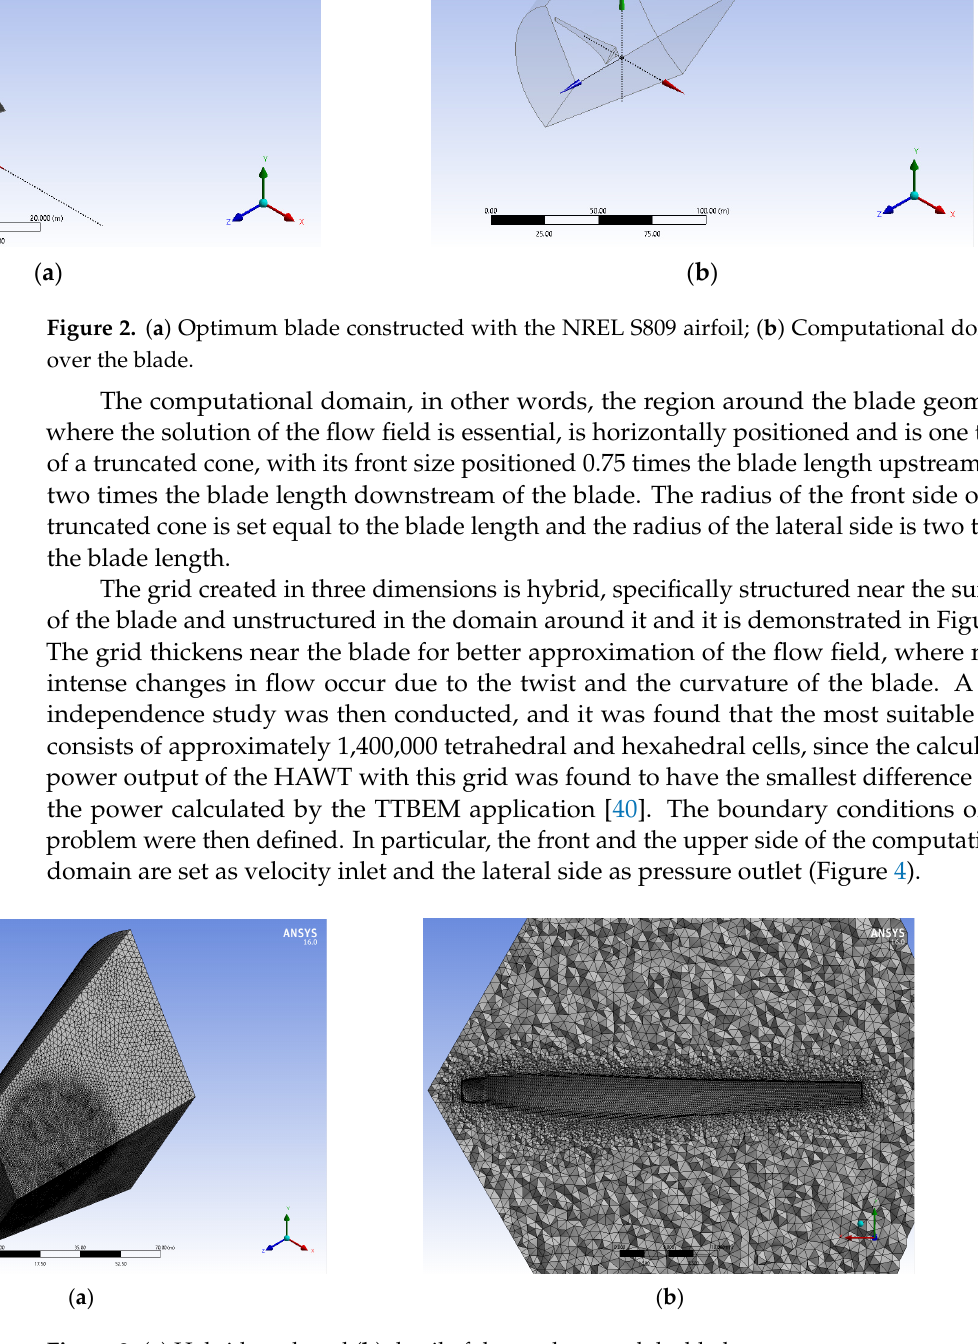
Figure 4. Computational domain and boundary conditions. 2.2. Simulation Procedure The simulated air velocities were set equal to 10 m·s − 1 and 15 m·s − 1 , which are typical air velocities for HAWTs’ operation. Two different air velocities were studied in order to show the dependence of air velocity on the performance of HAWTs under hailstorm con- ditions. Firstly, simulations of airflow over the blade were conducted and then of hail- storm conditions, so as to be able to compare not only the power output but the whole flow field as well. The SST k- ω turbulence model [43] was selected for the simulations, as it is the most suitable for such problems due to its ability to precisely predict adverse pressure gradient flows. The solution of the flow equations governing the rotation of the HAWT rotor in ANSYS Fluent 16.0 [42] is performed on a moving reference system, in relation to which the flow is considered stable over time. This is achieved by defining specific air zones as moving parts, while activating the Moving Reference Frame Model (MRF). The terms of acceleration, resulting from the conversion of the inertial reference system to rotating, are included in the equations of motion. Hailstorm simulation was accomplished by the Discrete Phase Model (DPM). Usu- ally, hailstorms occur simultaneously with rainfall; thus, hailstones and raindrops, con- sidered spherical particles, are dispersed in the air, which is the continuous medium. For